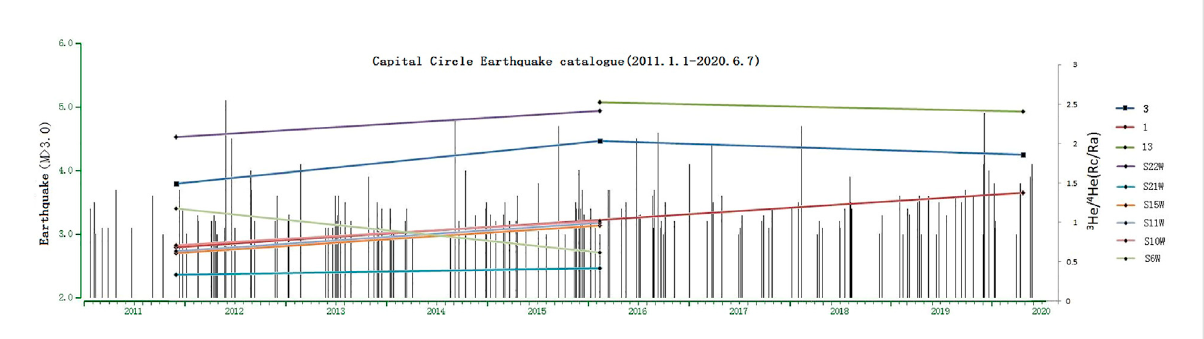
FIGURE 10 The relationship between seismic activities with percentage of mantle-derived He in hot spring gases along the Zhangjiakou-Bohai Fault